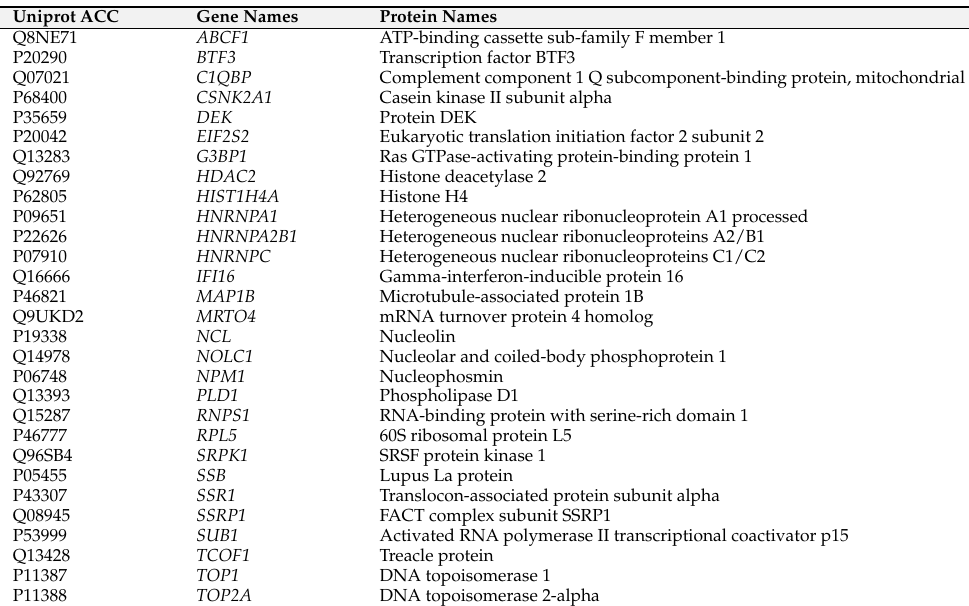
Table 1. Protein kinase CK2 substrates identified among the CIGB-300 interacting proteins in NCI- H460